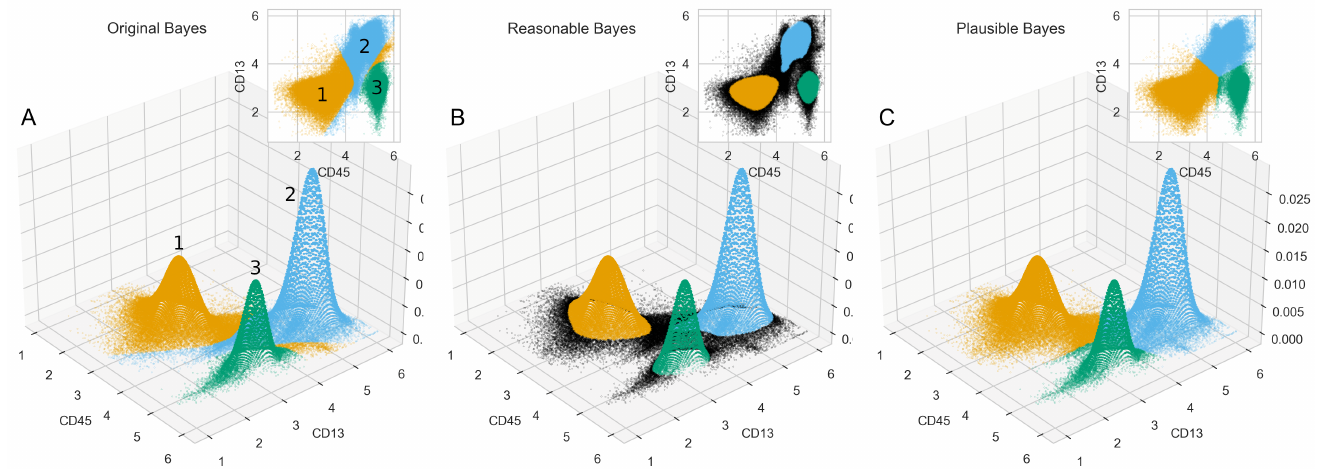
Figure 4. Three-dimensional dot plots of n = 296,755 cells from peripheral human blood analyzed by fluorescence-activated cell sorting (FACS) [19] and class assignment based on the Bayesian statistical method and modifications proposed in this report. Cells were labeled for d = 2 surface markers belonging to the CD45 and CD13 discrimination clusters. The distribution is modeled by three two- dimensional Gaussian curves whose parameters were fitted to the empirical data using the classical EM algorithm. Colors and class numbers are arbitrary for each class and indicate the assignment of each cell to one of the three modes based on ( A ) statistical reasoning using Bayes’ theorem or ( B ) “reasonable Bayes” classification as proposed here. Events shown in black have not been given a class label. ( C ) Plausible Bayes classification of the events, as suggested here: the Voronoi cells induced by the modes (= mean values) of the three Gaussian curves determine the class of the unlabeled data. For a precise localization of the classes, the insets show a top view of the data. The figure was created using Python version 3.8.12 for Linux (https://www.python.org (accessed on 18 September 2022)) and the “seaborn” statistical data visualization package (https://seaborn.pydata.org (accessed on